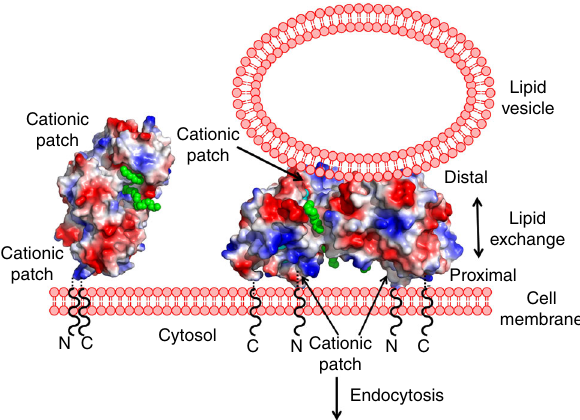
Fig. 6 Proposed mechanism of lipids traf fi cking by LIMP-2. Lipids (green spheres) binding of LIMP-2 monomer promote dimer formation. In the LIMP-2 dimer the luminal domains are closer to the cell membrane, with the proximal face of LIMP-2 luminal domain able to interact with the cell membrane while its distal face able to interact with extracellular lipid vesicles, respectively, via their cationic patches. Within the tethers of the protein on the luminal side, between the ends of the structurally de fi ned polypeptides and the transmembrane helices, there are suf fi cient residues that are fl exible and lack de fi ned secondary structure to enable this dimerization on cell surface: 24 residues after the last residue of the N- terminal transmembrane helix and 6 before the beginning of the C-terminal transmembrane helix. If fully extended, these tethers can stretch at least 20 Å. Notice the channels in LIMP-2 ectodomain dimer connect bound lipid vesicles and cell membrane, with openings near cationic patches in both faces that may facilitate lipids exchange between vesicles and outer lea fl et of the cell membrane. LIMP-2 bound lipid vesicles can be traf fi cked into